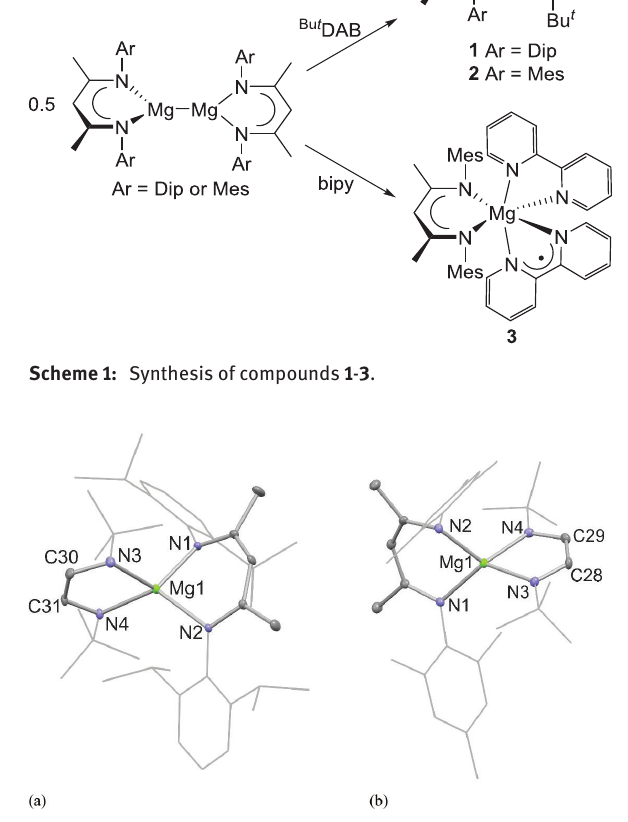
Figure 1: Thermal ellipsoid plot (25% probability surface) of the molecular structures of (a) 1 and (b) 2 (hydrogen atoms omitted; Dip, Mes and tert -butyl groups shown as wireframe for clarity).